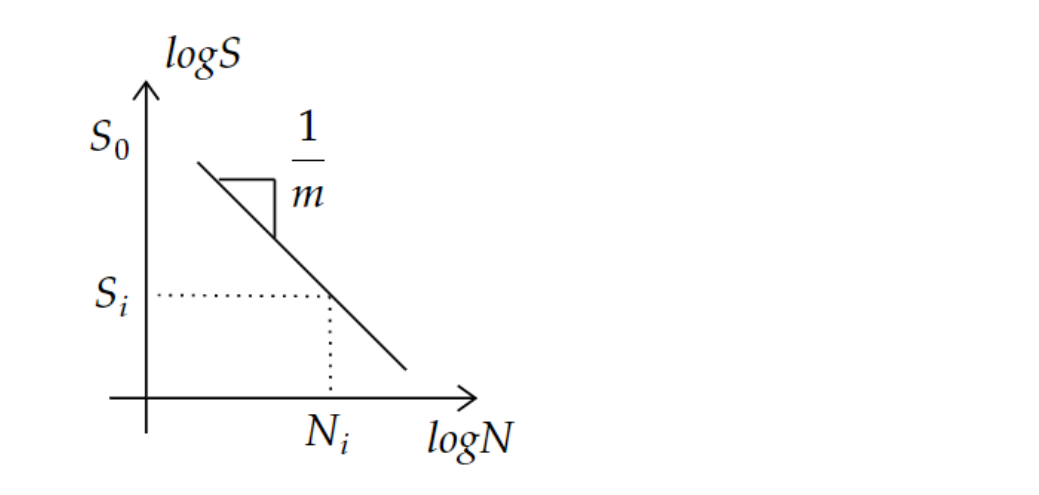
Figure 3. S–N curve : The relationship between the magnitude of alternating stress and the number of cycles to failure for a given